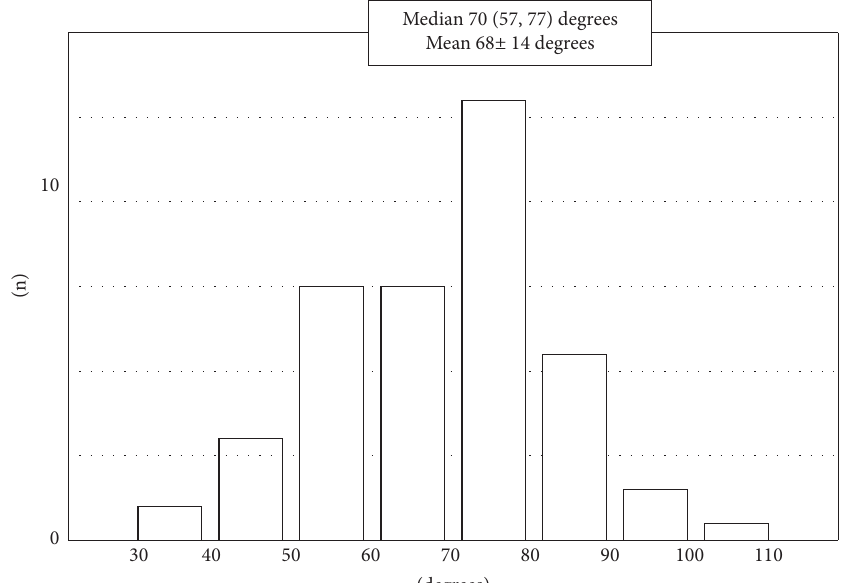
Figure 3: Distribution of the angle of the subclavian artery in the coronal view. Te median value was 70 (57, 77) degrees, and the mean value was 68 ± 14